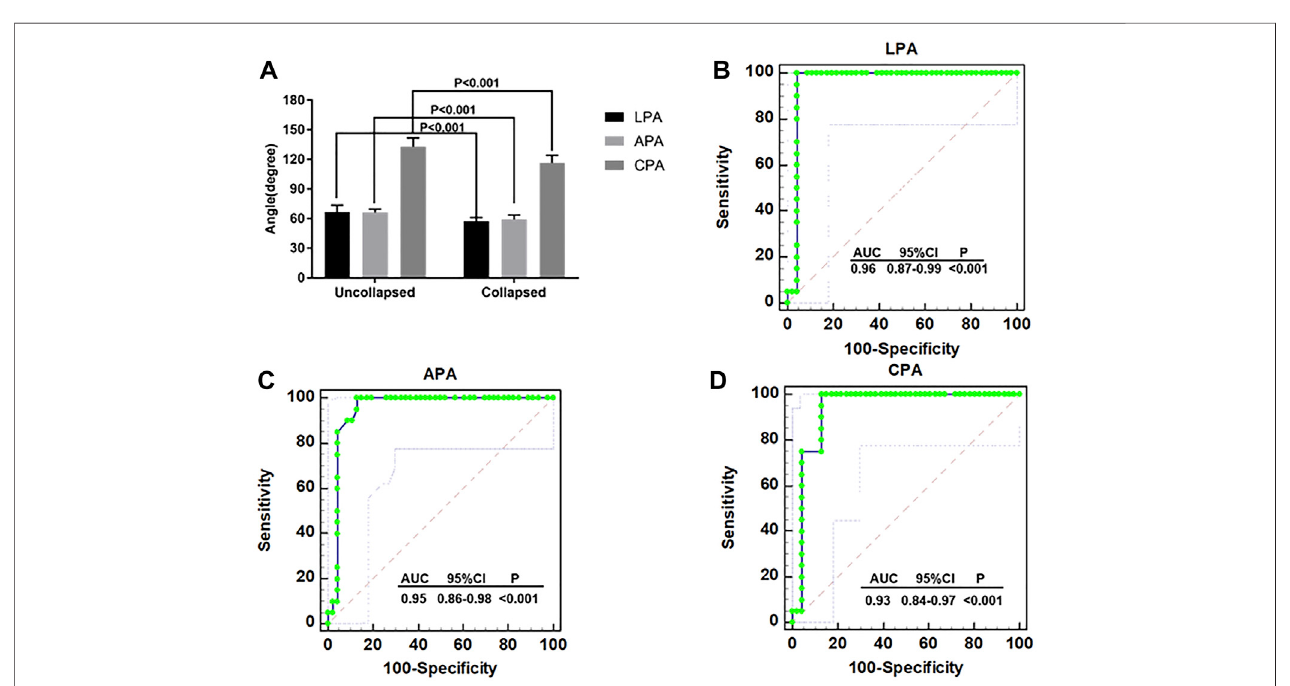
FIGURE 7 | ROC curve analysis (A) The LPA, APA, and CPA of patients without collapse were signi fi cantly higher than patients with collapse ( p < 0.001). (B) ROC curve analysis for the LPA in terms of predicting collapse (AUC (cid:1) 0.96, 95% CI 0.87 – 0.99, p < 0.001, cutoff value (cid:1) 60.9 ° , sensitivity (cid:1) 100%, speci fi city (cid:1) 95.65%). (C) ROCcurveanalysisfortheAPAintermsofpredictingcollapse(AUC (cid:1) 0.95,95%CI0.86 – 0.98, p < 0.001,cutoffvalue (cid:1) 62.21 ° ,sensitivity (cid:1) 100%,speci fi city (cid:1) 86.96%). (D) ROCcurveanalysisfortheCPAintermsofpredictingcollapse(AUC (cid:1) 0.93,95%CI0.84 – 0.97, p < 0.001,cutoffvalue (cid:1) 121.11 ° ,sensitivity (cid:1) 100%,speci fi city (cid:1)